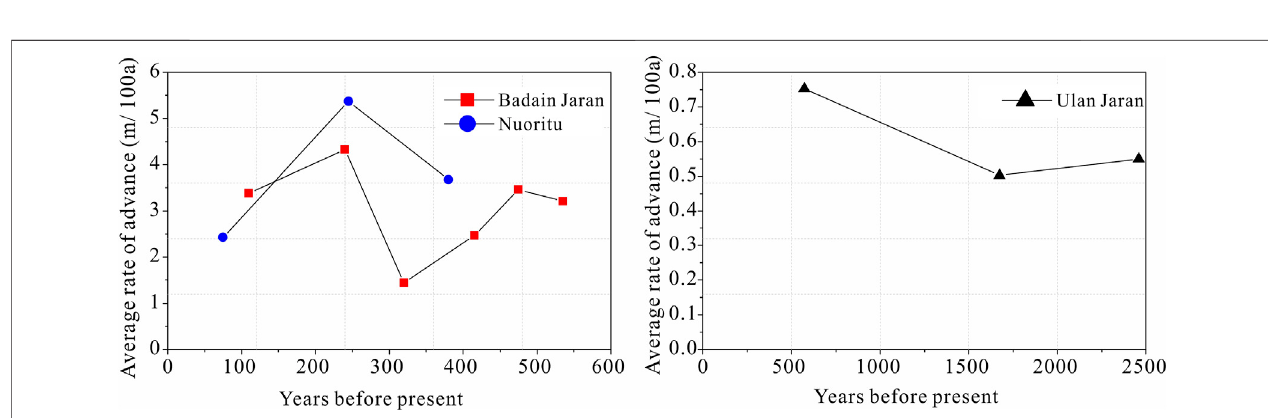
FIGURE 4 | Average advancement rate of the megadunes in different periods.